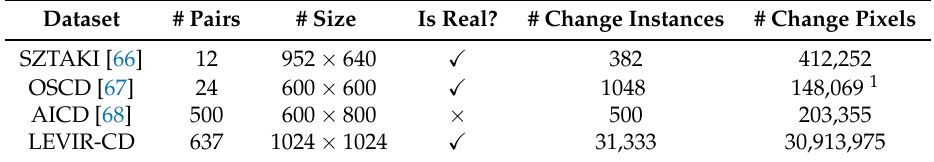
Table 3. A comparison of LEVIR-CD and other remote sensing image change detection datasets.